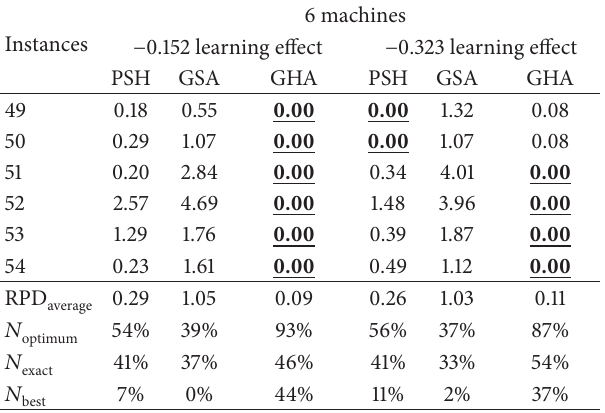
Table 6: Results of 6 machines